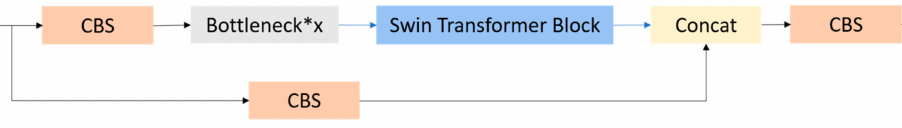
Figure 5. Schematic of C3SW-T.